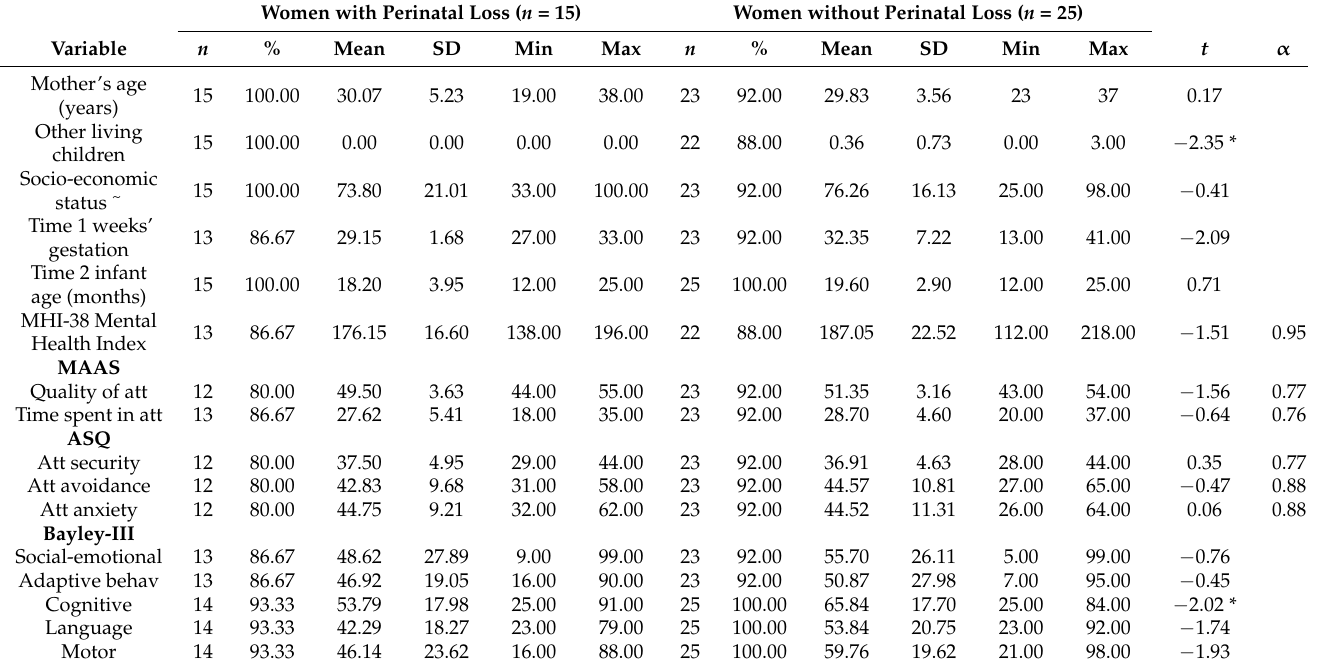
Table 2. Descriptive statistics of continuous variables for women with and without perinatal loss, N = 40. Women with Perinatal Loss ( n = 15) Women without Perinatal Loss ( n =